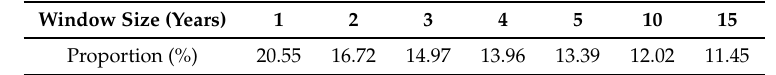
Table 5. Average proportion (%) of books occupying 50% of total loans for each window